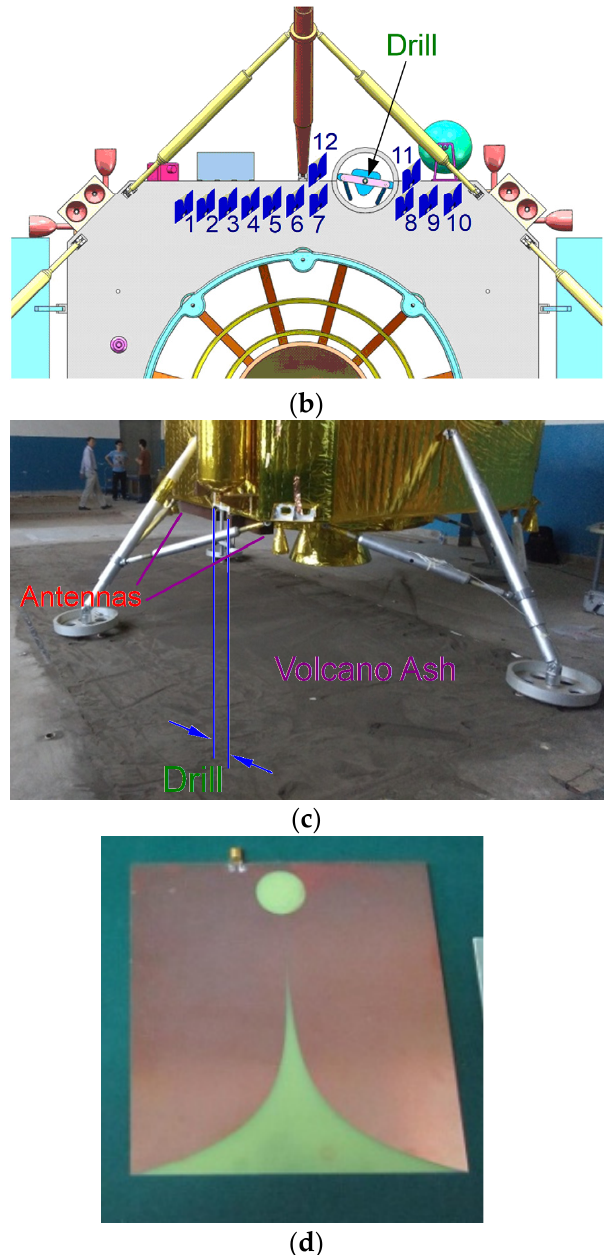
Figure 3. Diagram of 12 Vivaldi antennas on the CE-5 lander: ( a ) 3D view, ( b ) vertical view, ( c ) live photo for CE-5 lander, and ( d ) real Vivaldi antenna element.